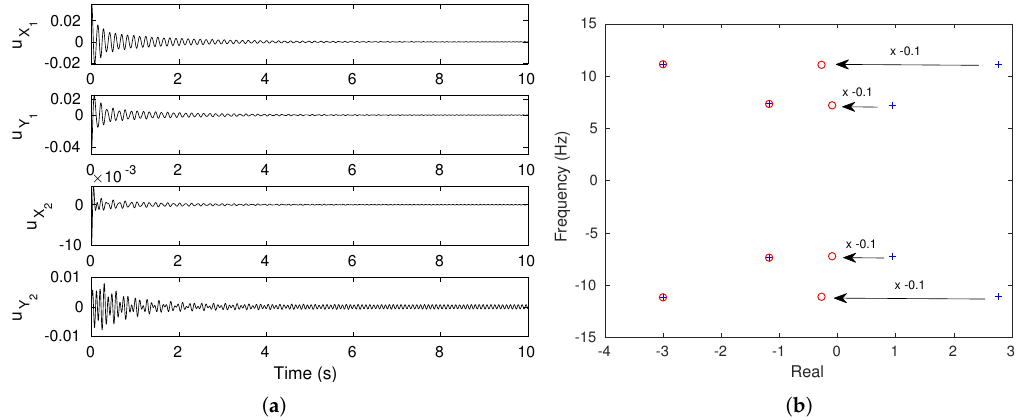
Figure 8. Control vector u applied to the displacements and poles chart with γ = − 0.1 and µ = 0.7. ( a ) Control vector. ( b ) Poles chart ( + uncontrolled poles; ◦ controlled poles).